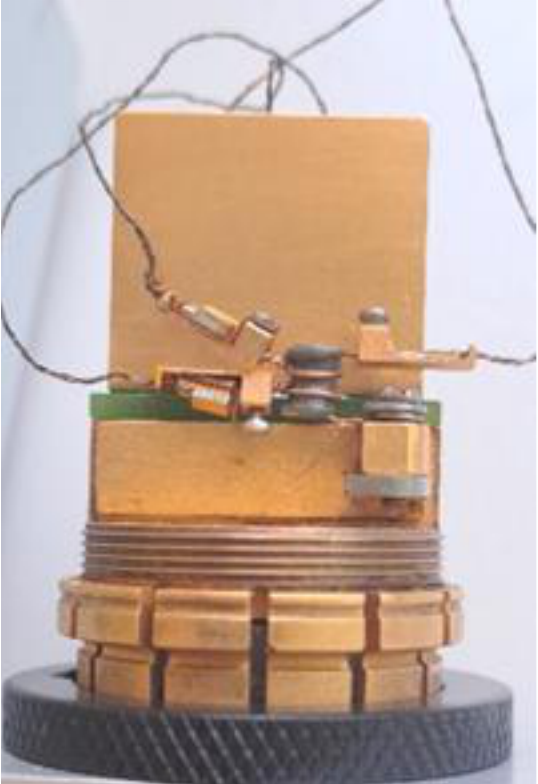
Figure 1. Detonated nanodiamond ceramic sample mounted on the TTO sample puck of PPMS in a 4-wire contact configuration.